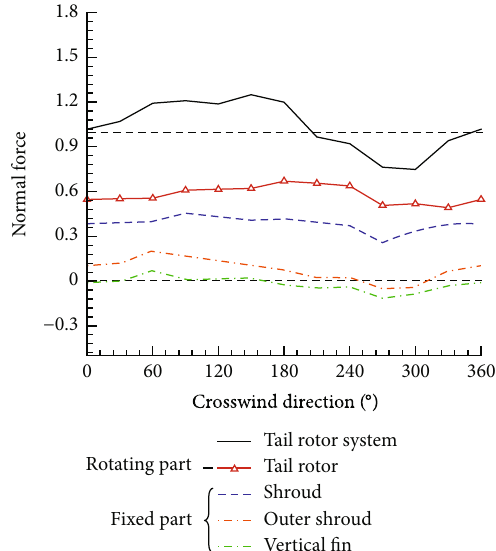
Figure 18: Components of normal force of the tail rotor system.